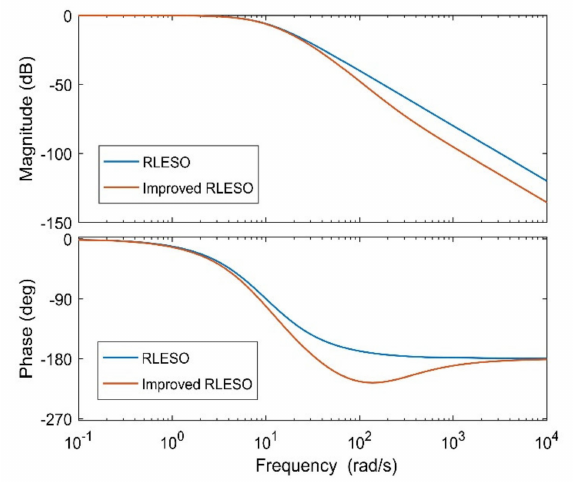
Figure 8. Comparison of the disturbance observation capabilities between RLESO and the improved